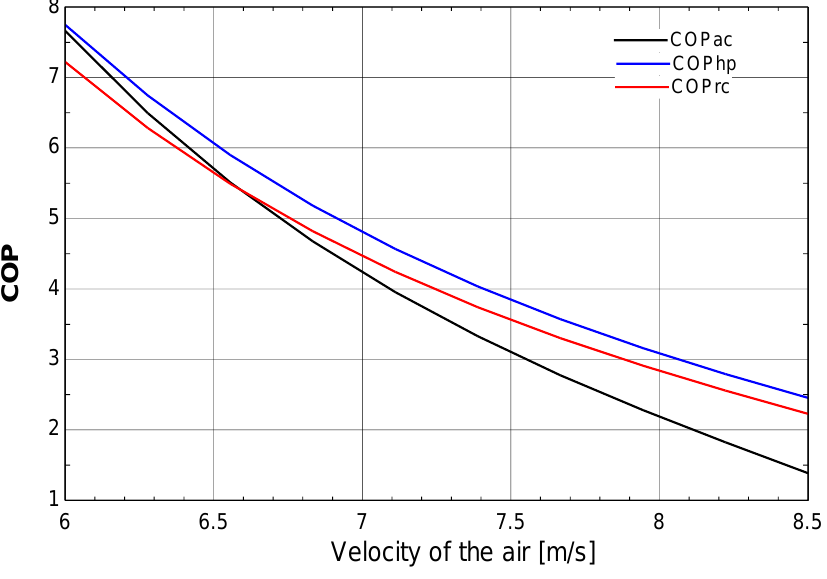
Figure 13. Effect of the velocity of the air on COP of heat pump, refrigeration cycle, and air-condi- tioning cycle.